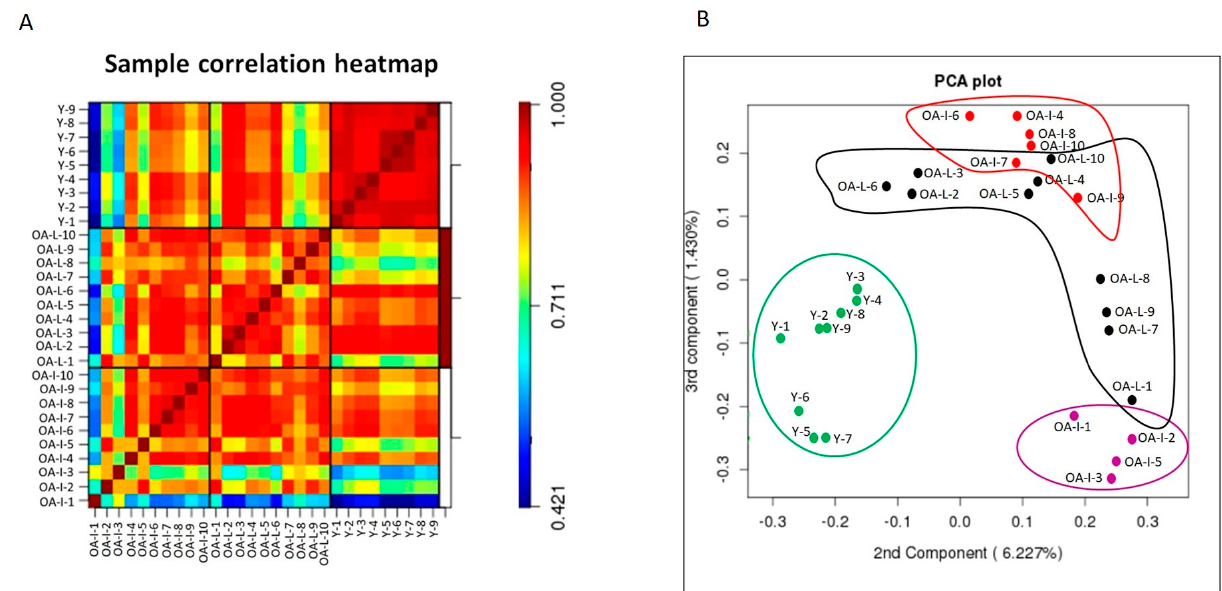
Figure 1. Microarray data visualisation. ( A ). Heatmap of sample correlation coefficients. Correlation coefficients following microarray analysis between young intact, old OA intact and lesioned cartilage samples were computed using log-transformed expression values of detected miRNAs. Colour gradient from blue to red denotes transition from low to high correlation coefficients. Heatmap generated in R. ( B ) 2D PCA plot of the second and third components of miRNA abundance in young intact, old OA intact and old OA lesioned samples. Clustering of young intact (Y), old OA intact (OA-I) and lesioned (OA-L) cartilage samples based on miRNA expression, following microarray analysis. Green: Young intact, magenta: old OA-Intact-1, red: old OA-Intact-2, black: old OA-Lesioned. Numbers (1 to 9 for young intact and 1 to 10 for old OA intact/lesioned) correspond to donor/patient number. PCA plot generated in R. Table 1. Number of significant DE miRNAs in human cartilage samples. Significant DE miRNAs are defined as those with FDR-adjusted p -value < 5%. OA-Lesioned/OA-Intact 1/OA-Intact-2: group of interest. Young: reference group. OA-Lesioned vs. OA-Intact-1 vs. OA-Intact-2 Young Young